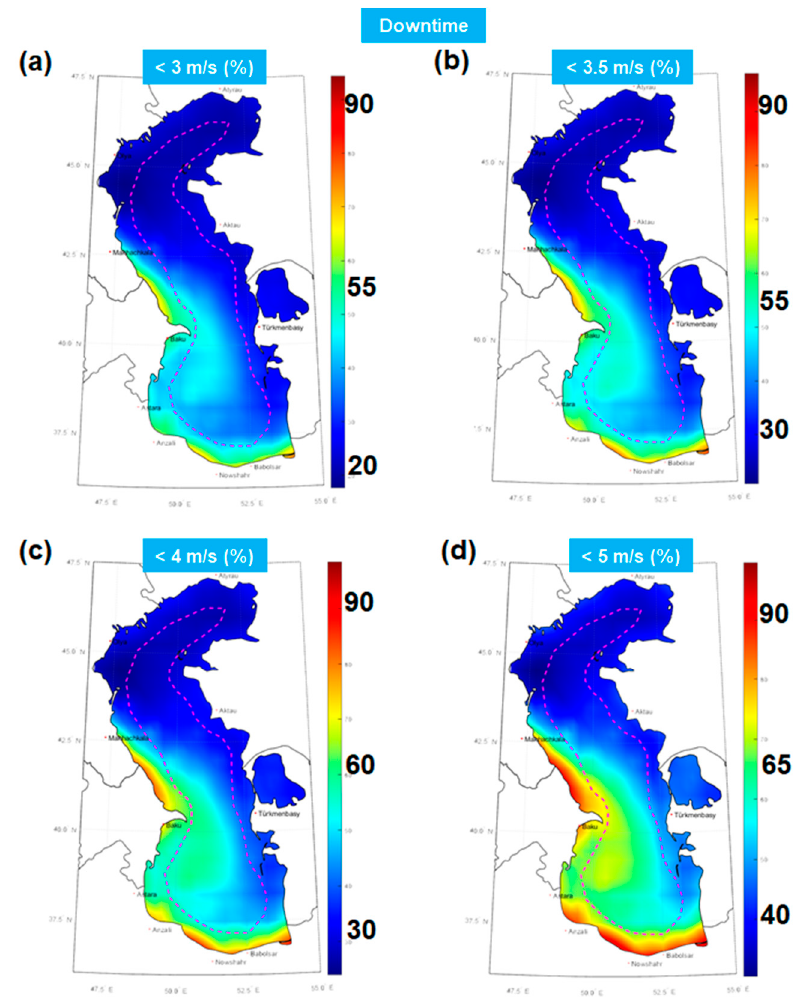
Figure 7. The downtime interval (%) corresponding to different cut-in values, where: ( a ) 3 m/s; ( b ) 3.5 m/s; ( c ) 4 m/s; ( d ) 5 m/s. The dotted line is located at approximately 50 km from the shoreline.